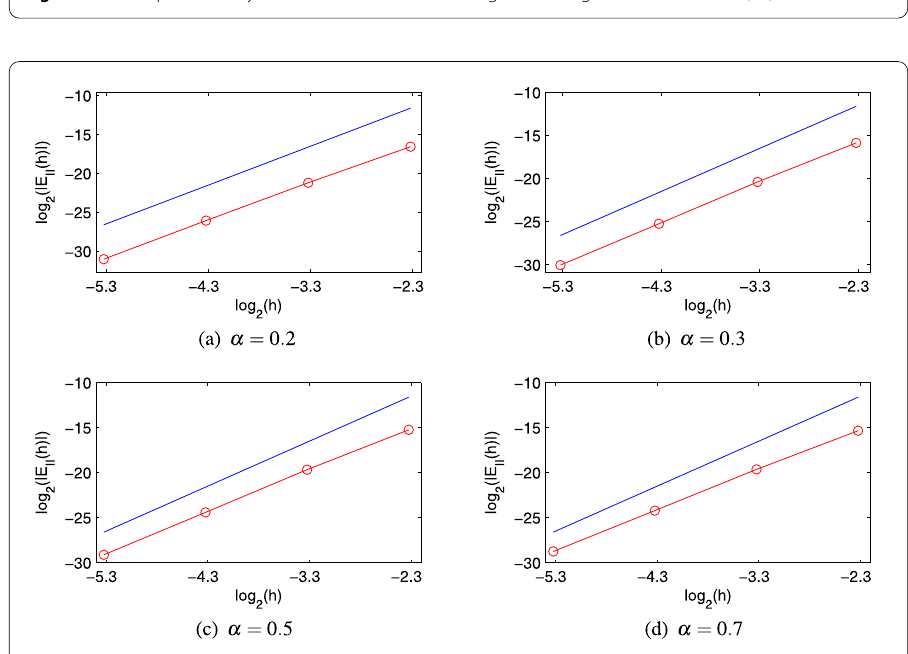
Figure 6 The experimentally determined orders of convergence for algorithm II at t = 1 for (31) with ν =